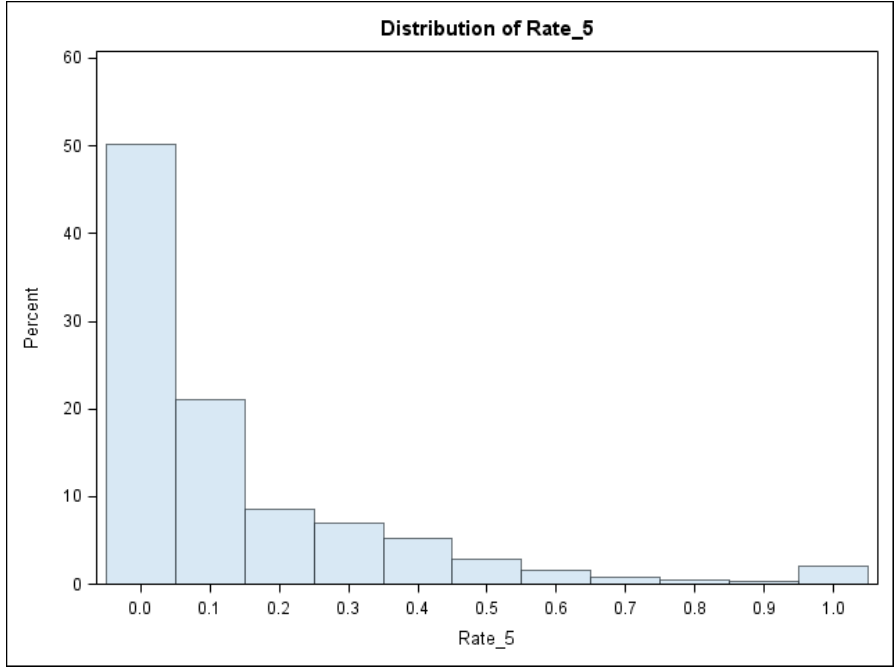
Figure 1. The histogram of the observed incident rate of children’s BLL ≥ 5 µg/dL in Syracuse, NY, USA. Table 2. Distribution summary of the response variable (the incident rate of children’s BLL ≥ 5 µ g/dL). Table 1. Descriptive statistics of variables used in this study (n = 1393). τ Variable Mean Std Dev Minimum Maximum Rate of BLL ≥ 5 µg/dL